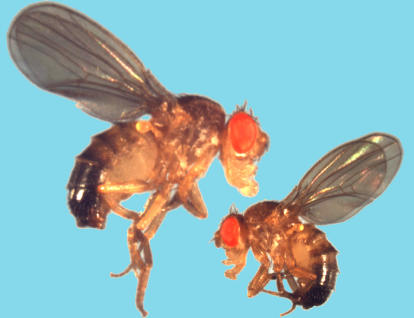
Experiments in the fruitfly show that insulin signaling controls body size, as well as organ size and total development time, by affecting cell growth and proliferation